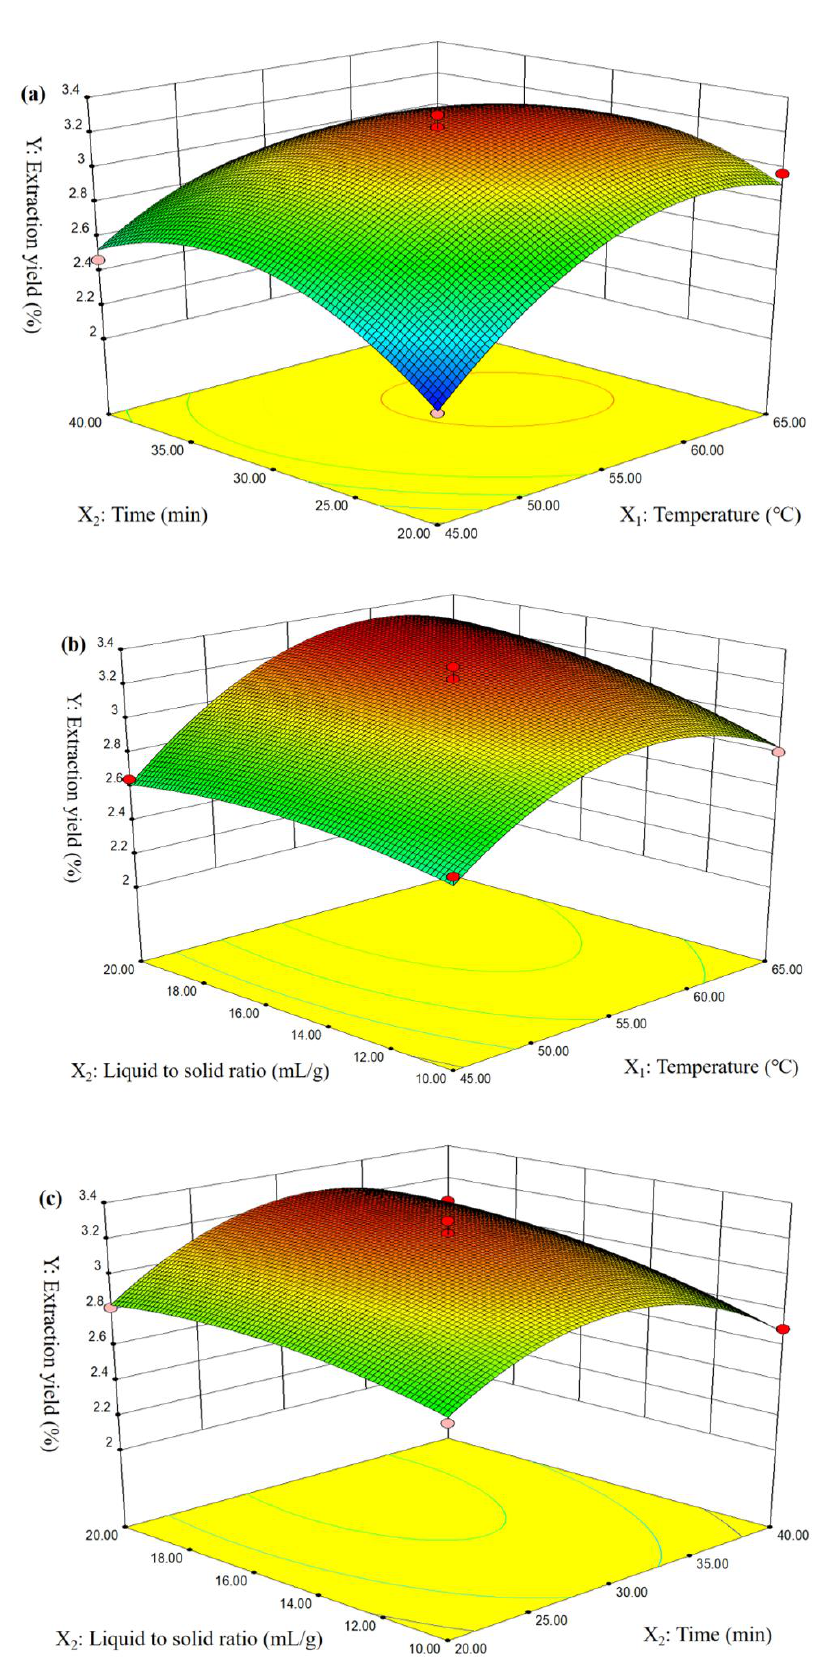
Figure 1. Effect of temperature ( X 1 ), time ( X 2 ), and liquid-to-solid ratio ( X 3 ) on the NRFP yield.